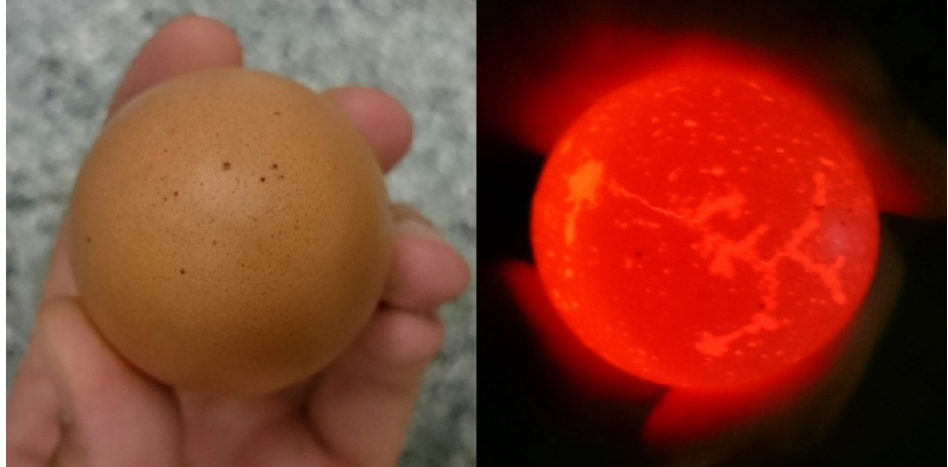
Figure 3. Seemingly intact egg ( left ) and cracks revealed on the same egg by a bright light shining through ( right ).